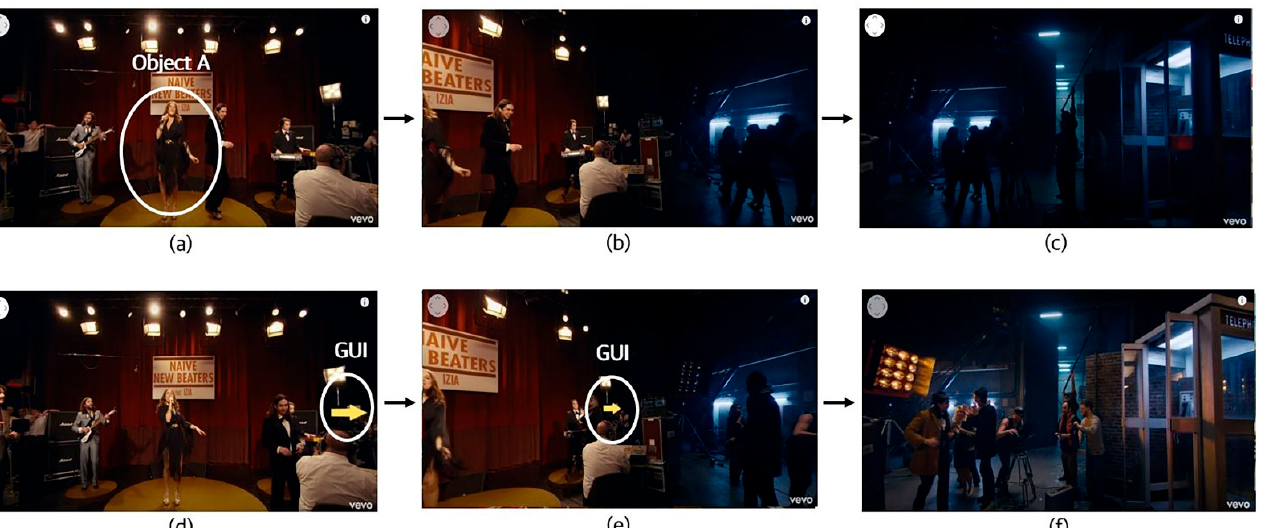
Figure 4. Directed Case 2 using “Hand gesture” (video No. 6). ( a ) The marked object A is beckon- ing in the direction of the arrow, ( b ) Object A and B are beckoning to the right, ( c ) The user can see object C, the main character, is dancing in the position intended by the director.